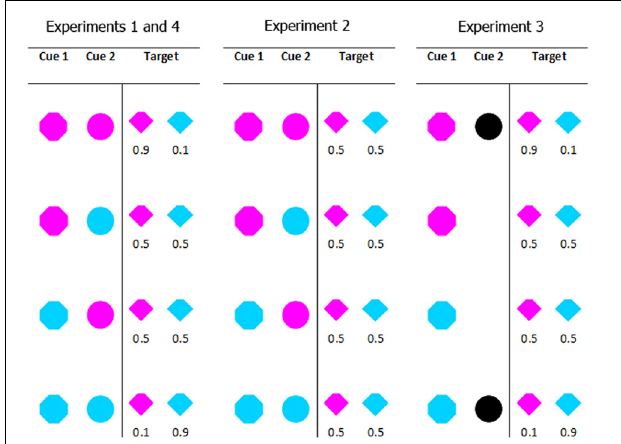
FIGURE 2 | All possible cue combinations and their associated target color probabilities for each experiment. Experiments 1 and 4 used the same cue conditions (in Experiment 4 we manipulated the instructions given to participants). In Experiment 1 when both cues were the same color (cyan or magenta) the target was 90% likely to be that color. When the cues were different colors, they were uninformative as to the target color. In Experiment 2, all cue combinations were uninformative. In Experiment 3, the presence or absence (counterbalanced across participants) of cue 2 indicated the validity of cue 1; a valid cue 1 predicted target color with 90%